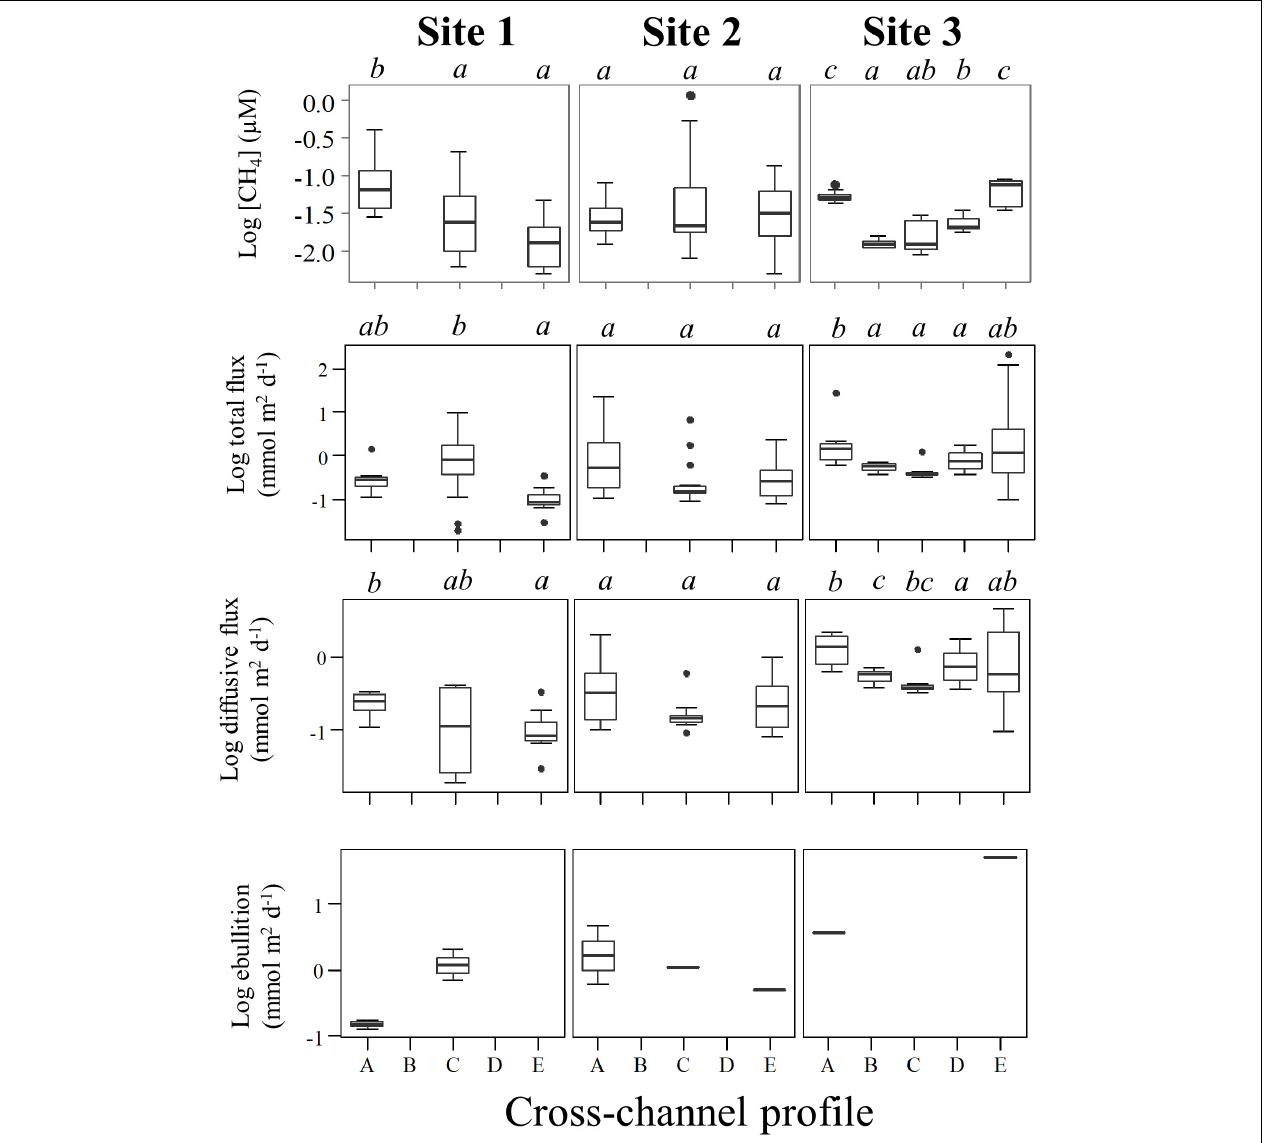
FIGURE 4 | Box-plots of the cross-channel profiles from the left bank (A) to right bank (E) of CH 4 concentration, diffusive flux, ebullition, and total flux in log scales. The boxes include the median flux and the quartile range (Q3–Q1; where Q denote quartiles). The whiskers include all data within the range (Q1–1.5(Q3–Q1)) to (Q3+1.5(Q3–Q1)). The black dots show data outside this range. Small italic letters above charts show grouping according to ANOVA, p < 0.01 followed by a Tukey post-hoc test ( p < 0.05). Ebullition does not show grouping statistics because of the small number of occurrences, and consequently, not meeting assumptions requirements for the statistical